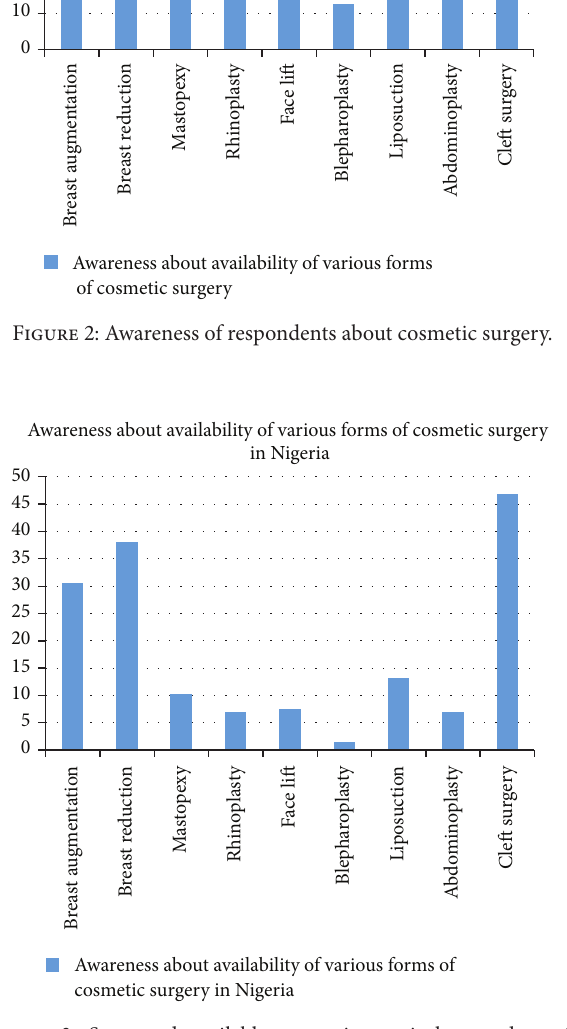
Figure 3: Suggested available cosmetic surgical procedures in Nigeria by